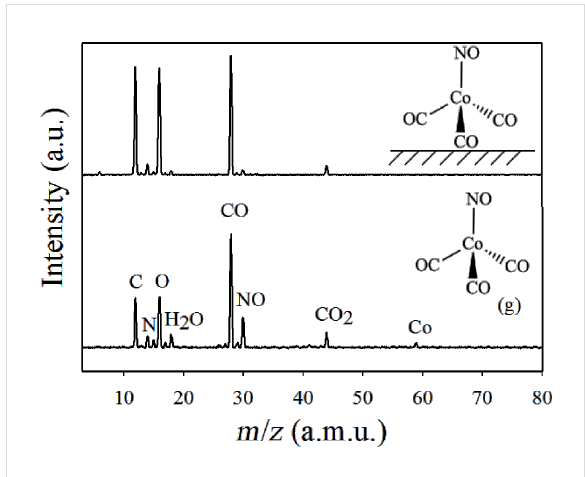
Figure 21: Positive ion (DI) mass spectra of (a) gas phase Co(CO) 3 NO, (b) volatile species desorbing from a 2.5 nm thick Co(CO) 3 NO film, adsorbed onto a gold substrate at 105 K, during ir- radiation with an electron dose of 5 × 10 16 e − /cm 2 at an electron energy of 500 eV (reproduced with permission from [25], Copyright (2013) American Chemical Society).